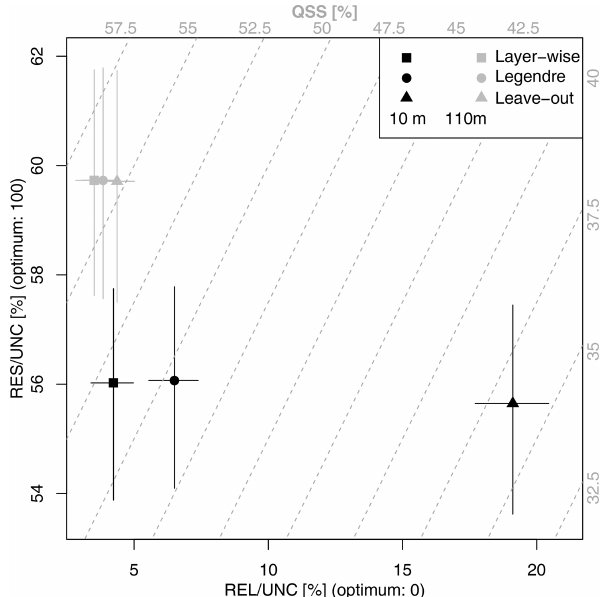
Figure 7. Decomposition of the QSS of the predictive 99% quantile at 10m (black) and 110m (grey) into scaled resolution (RES/UNC) and scaled reliability (REL/UNC) for the layer-wise, Legendre, and leave-out models. The crosses show the range of the 100-member bootstrap samples. The grey dashed lines indicate the QSS. The QSS amount is given on the upper and the right axes (grey num- bers).